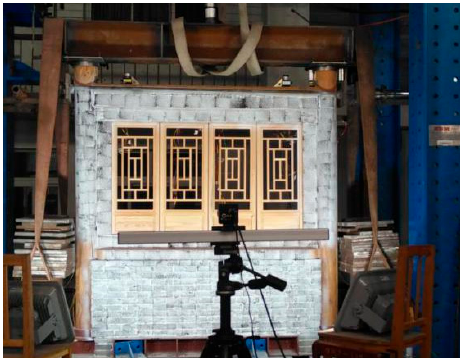
Figure 9. Loading scheme.